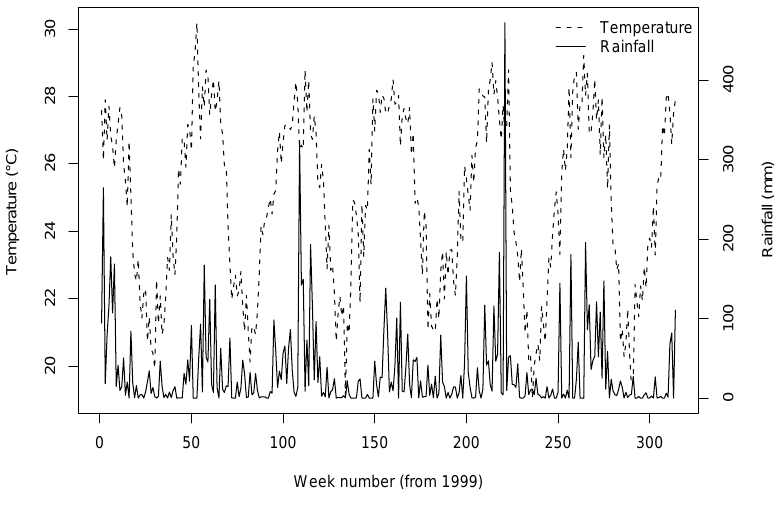
Figure 2: Temperature and rainfall variables used in the